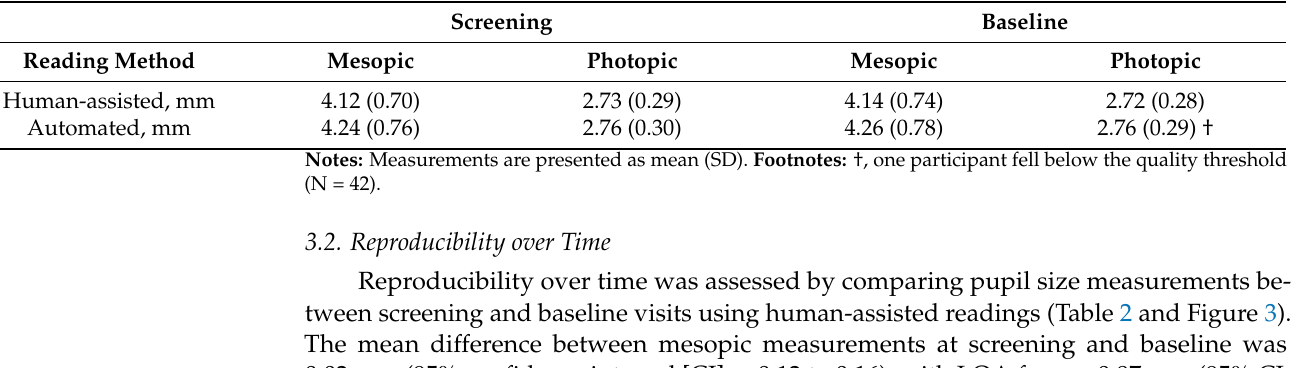
Table 1. Mean pupil size measurements.